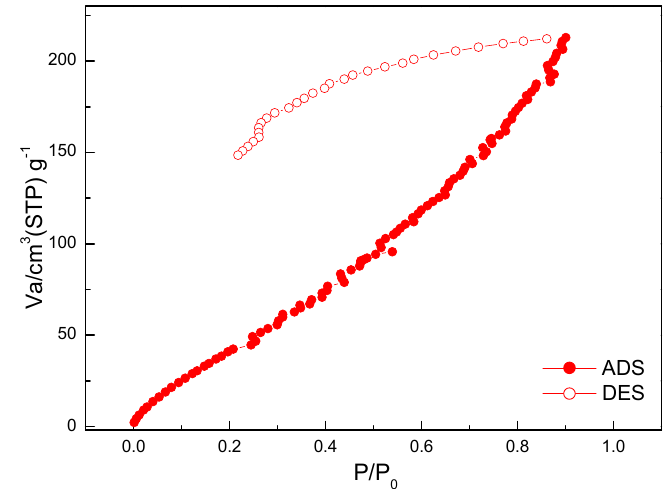
Figure 6. Water vapor ad-/desorption isotherms of dehydrated 1 at 298 K.